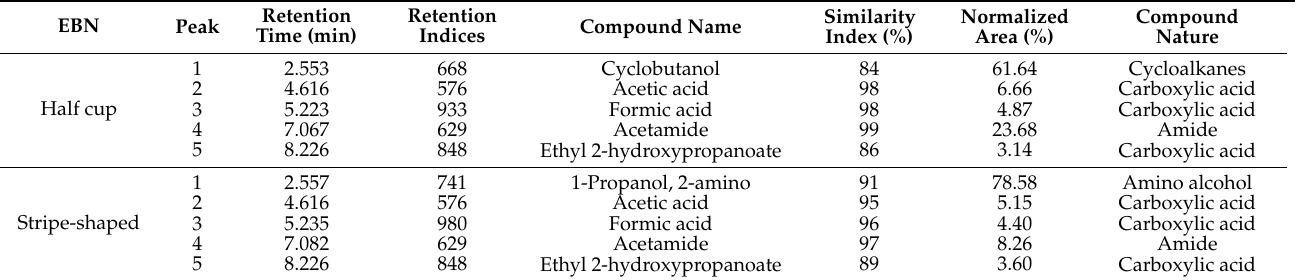
Table 2. Metabolite composition of the half cup and stripe-shaped EBN analyzed by